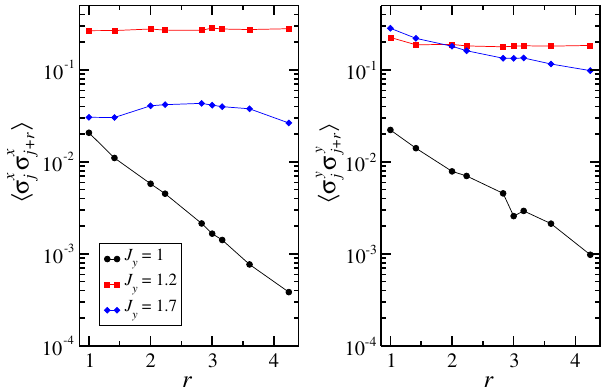
FIG. 11. The two-point xx (left panel) and yy (right panel) correlations as a function of the distance r in a two-dimensional square-lattice geometry. The calculations have been performed on a square lattice of size l ¼ 4 , while the point j has been chosen to be at one of the corners of the more-square cluster. The three sets of data refer to different values of J y according to the legend: two inside the PM phase ( J y ¼ 1 and J y ¼ 1 . 7 ) and one inside the FM phase ( J y ¼ 1 . 2 ). We fixed J x ¼ 0 . 9 , J z ¼ 1 .